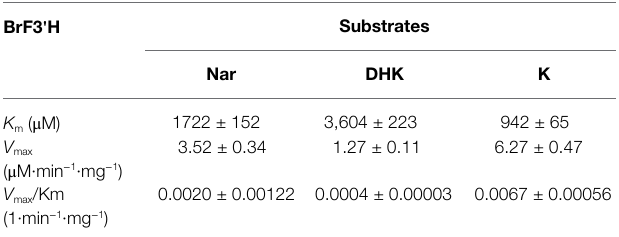
TABLE 2 | Kinetic parameters for 3 ' -hydroxylation activity of recombinant Br F3 ' H. BrF3 '